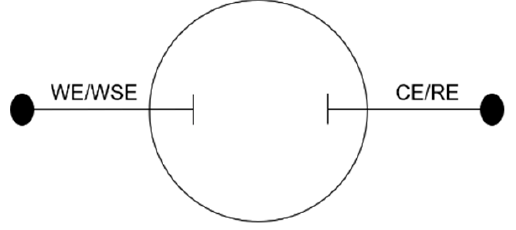
Figure 5. The schematics of the two-electrode setup, the working (WE) and working sense (WSE) connected to the anode and the counter (CE) and reference electrode (RE) connected to SS